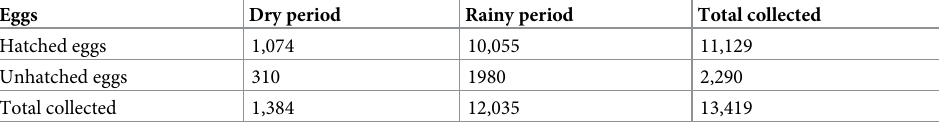
Table 1. Abundance of mosquito eggs collected during dry and rainy periods in the SANA Environmental Protec- tion Area, Macae´, Rio de Janeiro, Brazil, from 2016 to 2018.